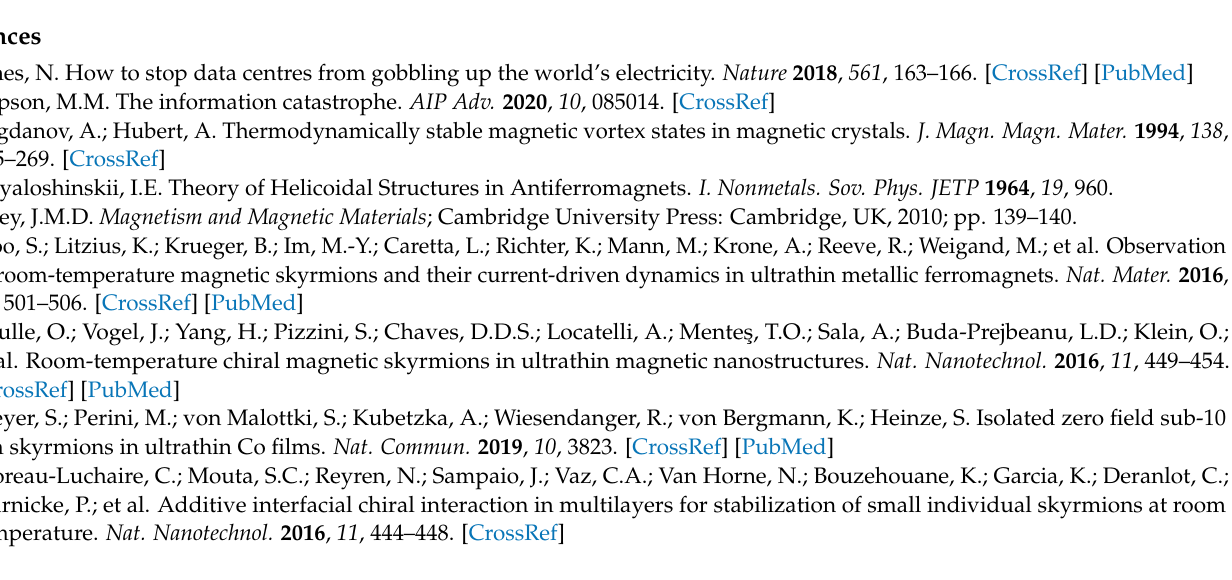
Figure A3. Skyrmionic state at T = 300 K for: ( a ) DMI = 5 mJ/m 2 and ( b ) DMI = 2.5 mJ/m 2 . The calculation has been performed for a 90 nm disk with the following parameters: DMI = 5 mJ/m 2 , K u = 1.7 × 10 +6 J/m 3 , M s = 1714 kA/m, A ex = 2.1 × 10 +11 J/m; the Gilbert damping constant α = 0.01. In each panel, the top image is a glyph representation of the magnetization vector field within the disk. The bottom image is a scalar field representation of the m z values.